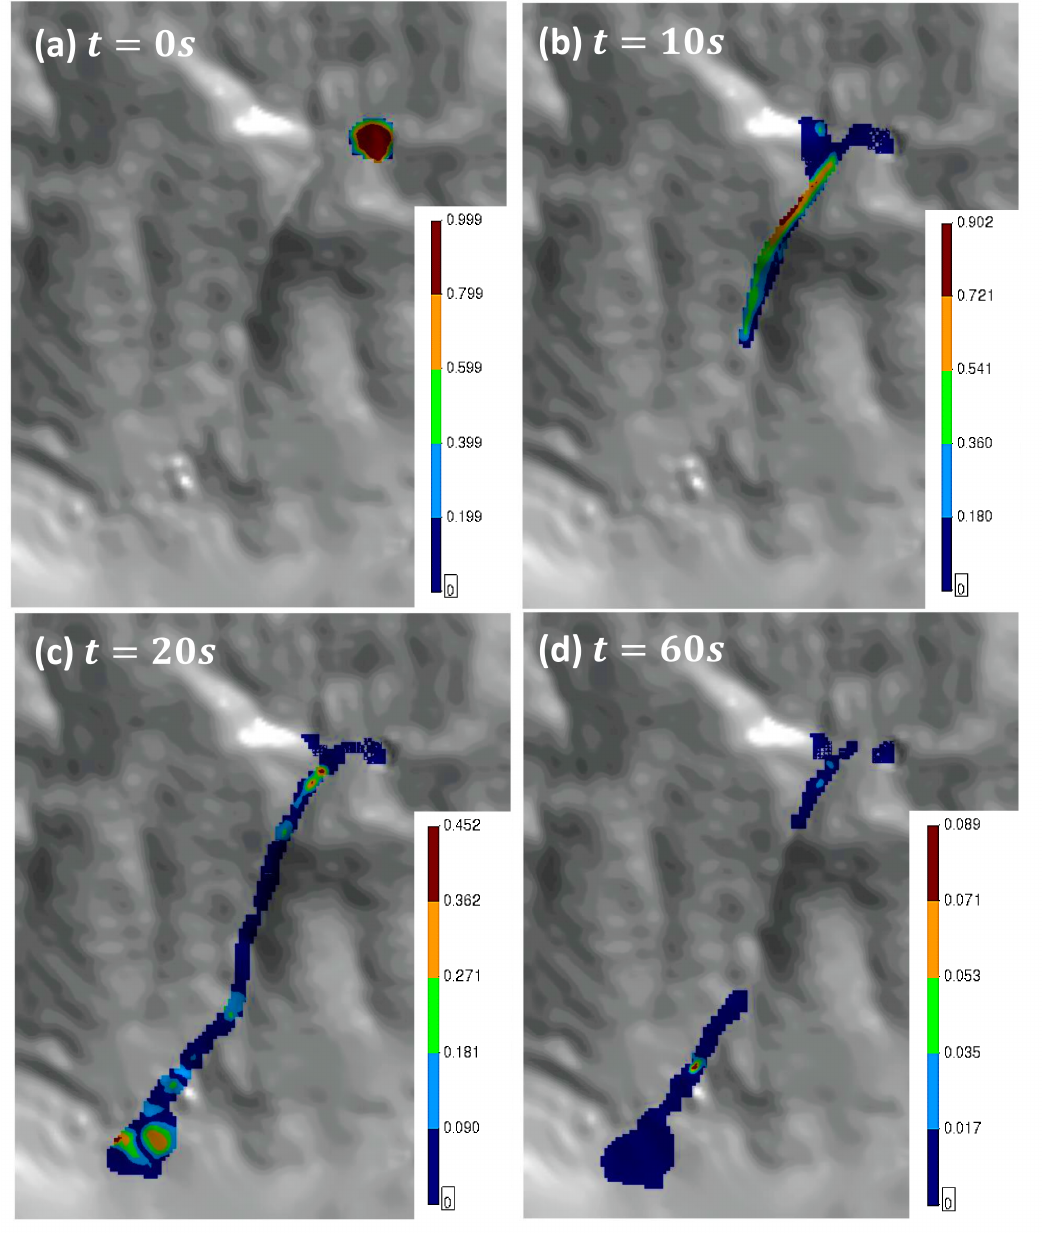
Figure 9. The distribution of relative pore–water pressure at ( a ) 0 s, ( b ) 10 s, ( c ) 20 s, and ( d ) 60